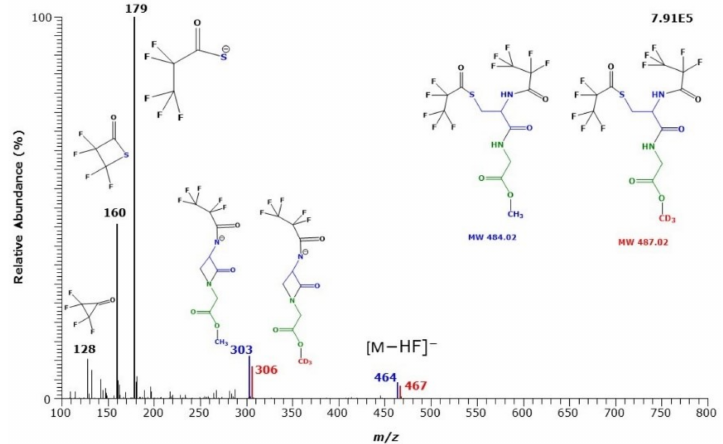
Figure 10. ECNICI mass spectra: GC-MS peaks with retention time of 5.50 min (TP#1), obtained from the separate derivatization of two 10 nmol aliquots of synthetic glutathione disulfide (GSSG) with 2 M HCl/CH 3 OH or 2 M HCl/CD 3 OD, and subsequent combined acylation with PFPA (30 min, 65 ◦ C). The quadrupole was scanned in the m / z -range 100–800 (1 scan/s). Inserts indicate the proposed